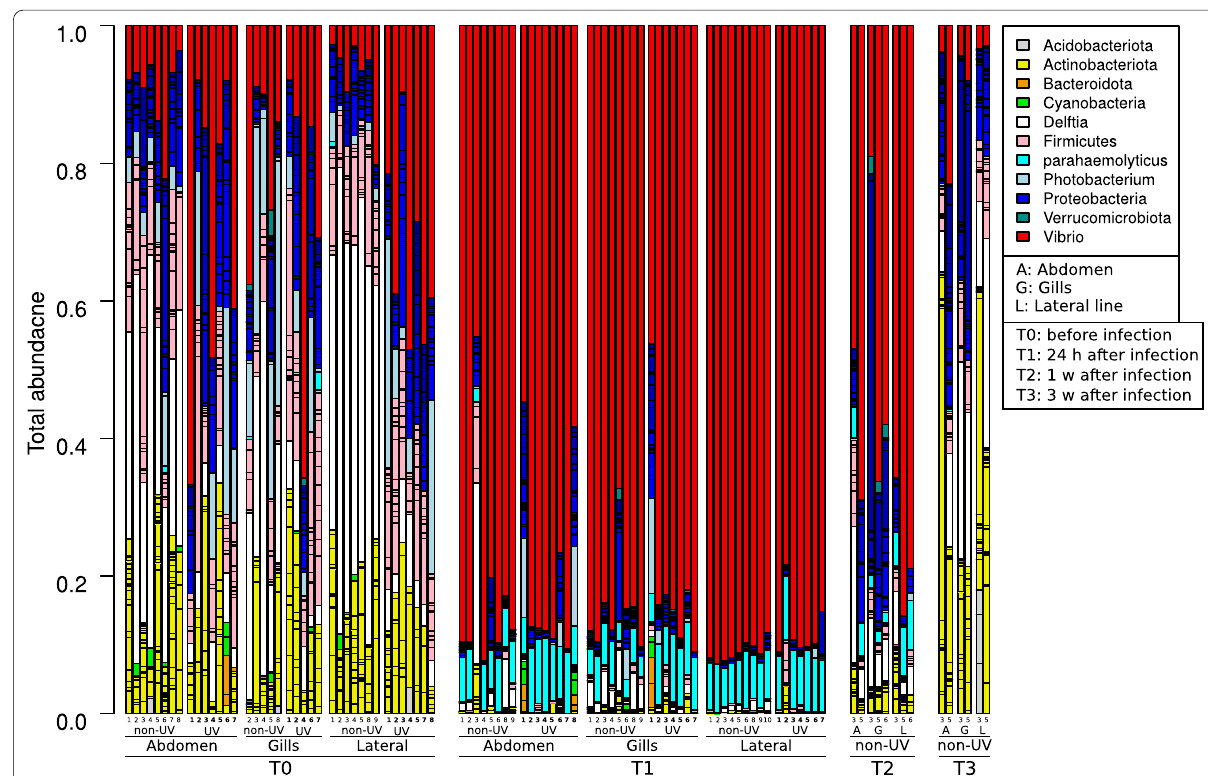
Fig. 5 Bar graph illustrating relative abundances of different bacterial phyla (different colors). Each bar represents one (tagged) fish, at different time points (Before infection T 0 and 24 h T 1 ; one‑week T 2 ; three‑weeks T 3 post infection), body sites for both UV and non‑UV treatments during V. harveyi infection in winter,